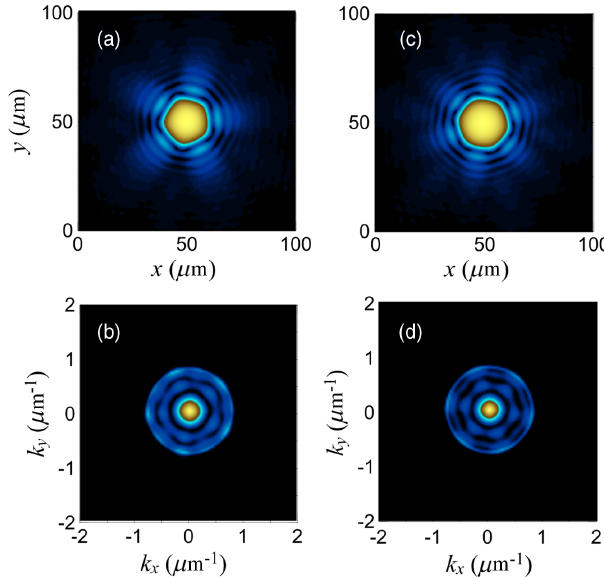
FIG. 8. Calculated polariton density distributions above bist- ability threshold. Intensity profiles of steady-state solutions are shown in real (a),(c) and momentum (b),(d) space. (a),(b) Pentagon state for A 2 0 ¼ 0 . 09 . (c),(d) Hexagon state for A 2 0 ¼ 0 . 16 . Other parameters are similar to those of Fig.